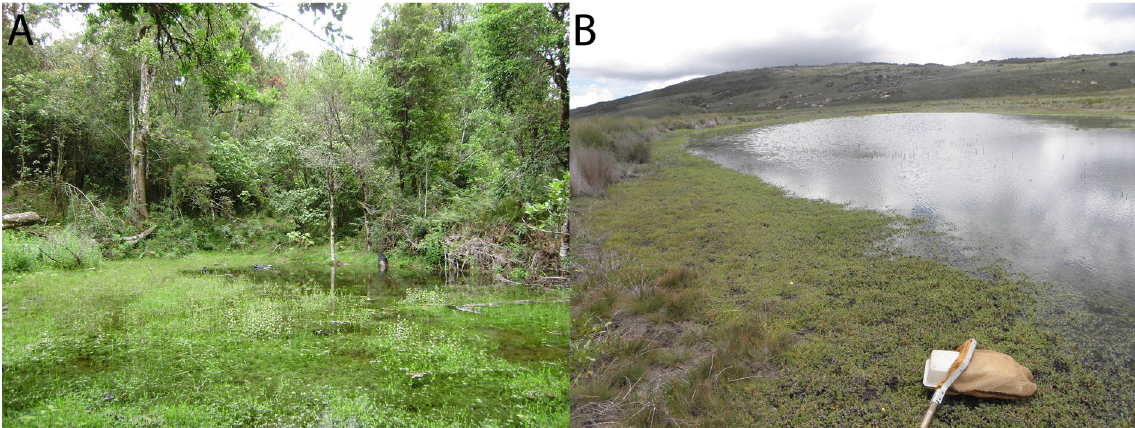
Fig. 6. Two localities of the high-altitude alpine species Bidessus nesioticus Guignot, 1956 previously known but from the type locality at 2500 m a.s.l. near the peak Tsiafajavona of Ankaratra mountain. A . A glade swamped by water from a source [MAD-MJK12-13] in Manjakatompo Ankaratra, 2070 m a.s.l. B . The new location [MAD13-33] of Bidessus nesioticus Guignot, 1956 at a pond in the alpine zone 2030 m a.s.l. on the Andringitra mountain massif in Andringitra